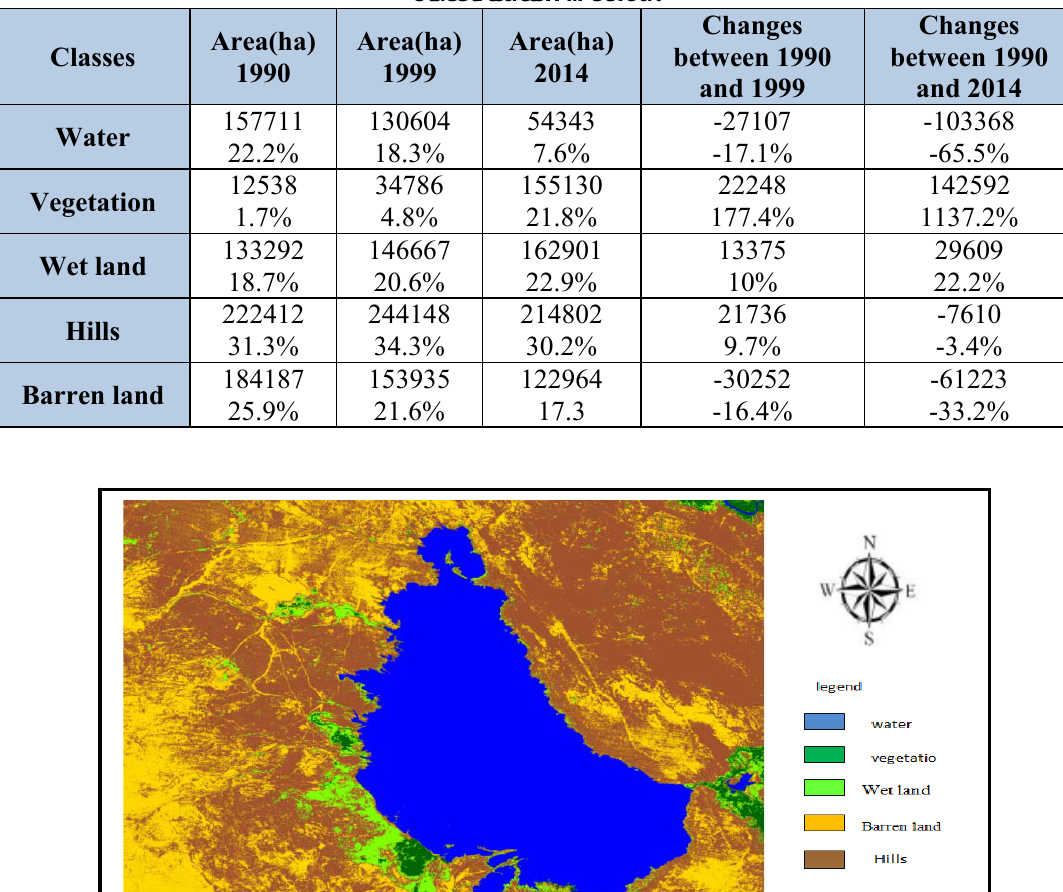
Fig.13: Unsupervised classification using K-Means classification method for Landsat-8 (2014). Table 3: The change in the years 1999, 2014 comparing with 1990 using K-Means classification method.